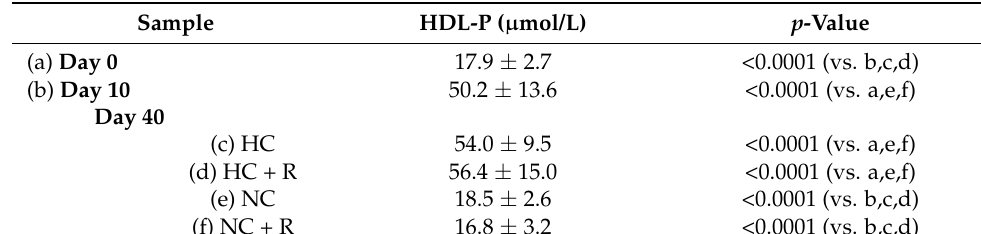
Table 1. Effects of diet and rosuvastatin intervention on HDL particle number. Data are reported as mean ± SD. HC: hypercholesterolemia; NC: normocholesterolemia; R: rosuvastatin.